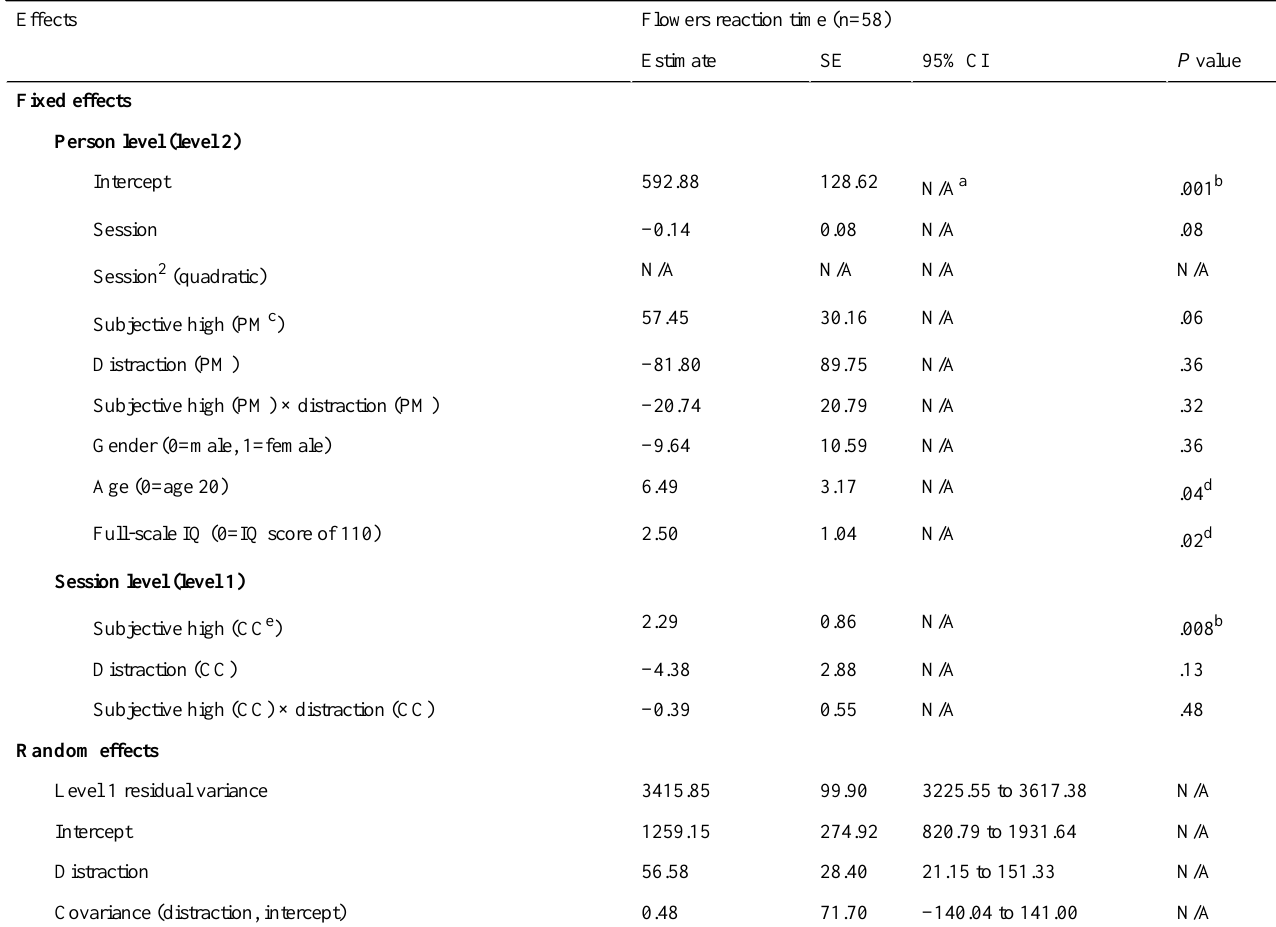
Table 3. Flowers task: multilevel model of marijuana high in relation to reaction